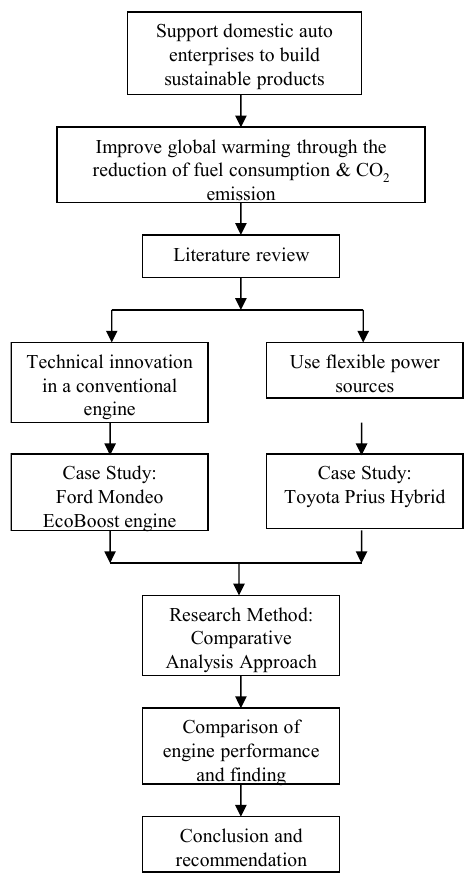
Figure 1. The research